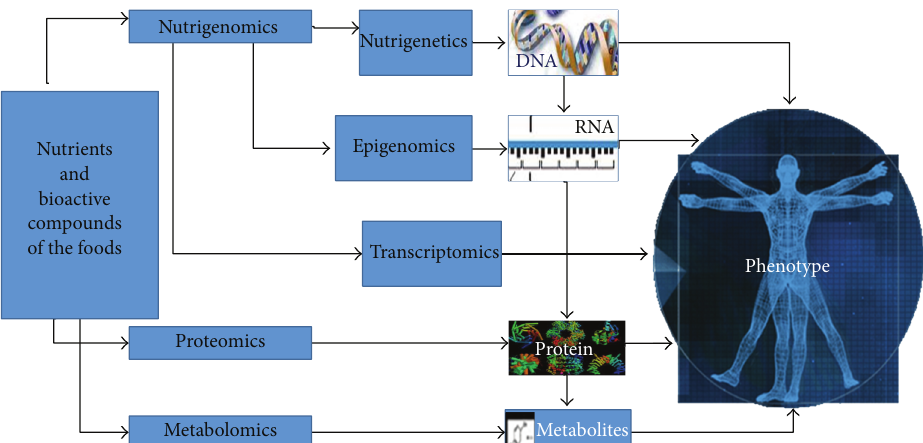
Figure 1: “Omics” sciences used in understanding the relationship between nutrition versus health versus disease (source: [4], with modifications; [9] with